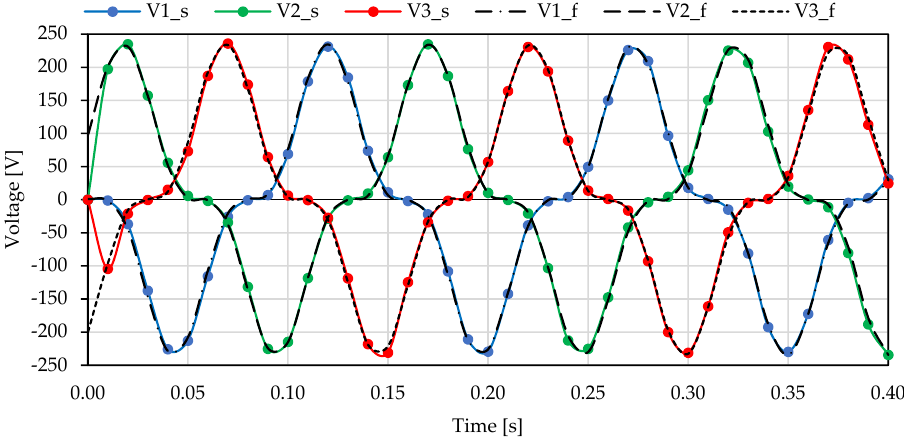
Figure 9. No-load voltages produced by prototype, with a translator speed equal to 1 m /